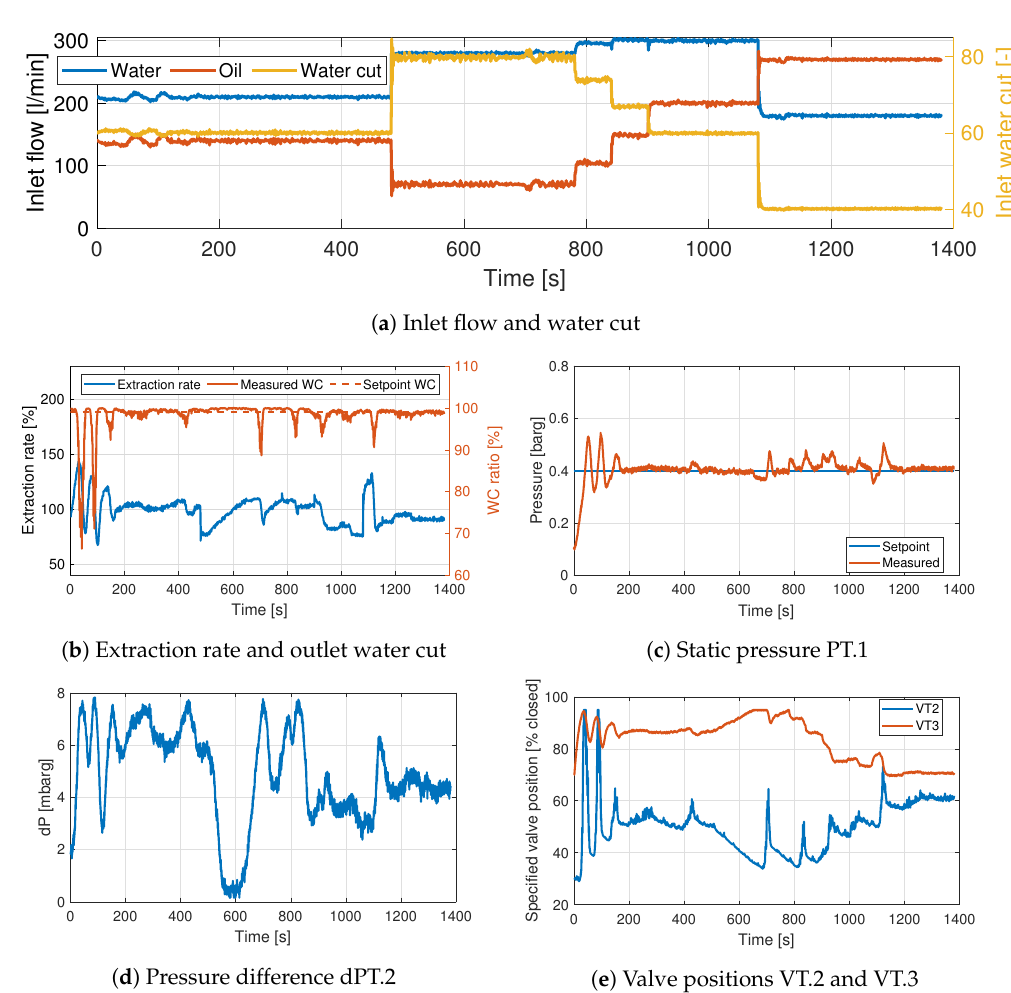
Figure 8. Experiment 2. PI controllers on VT.2 and VT.3, with the pairing recommended by the RGA